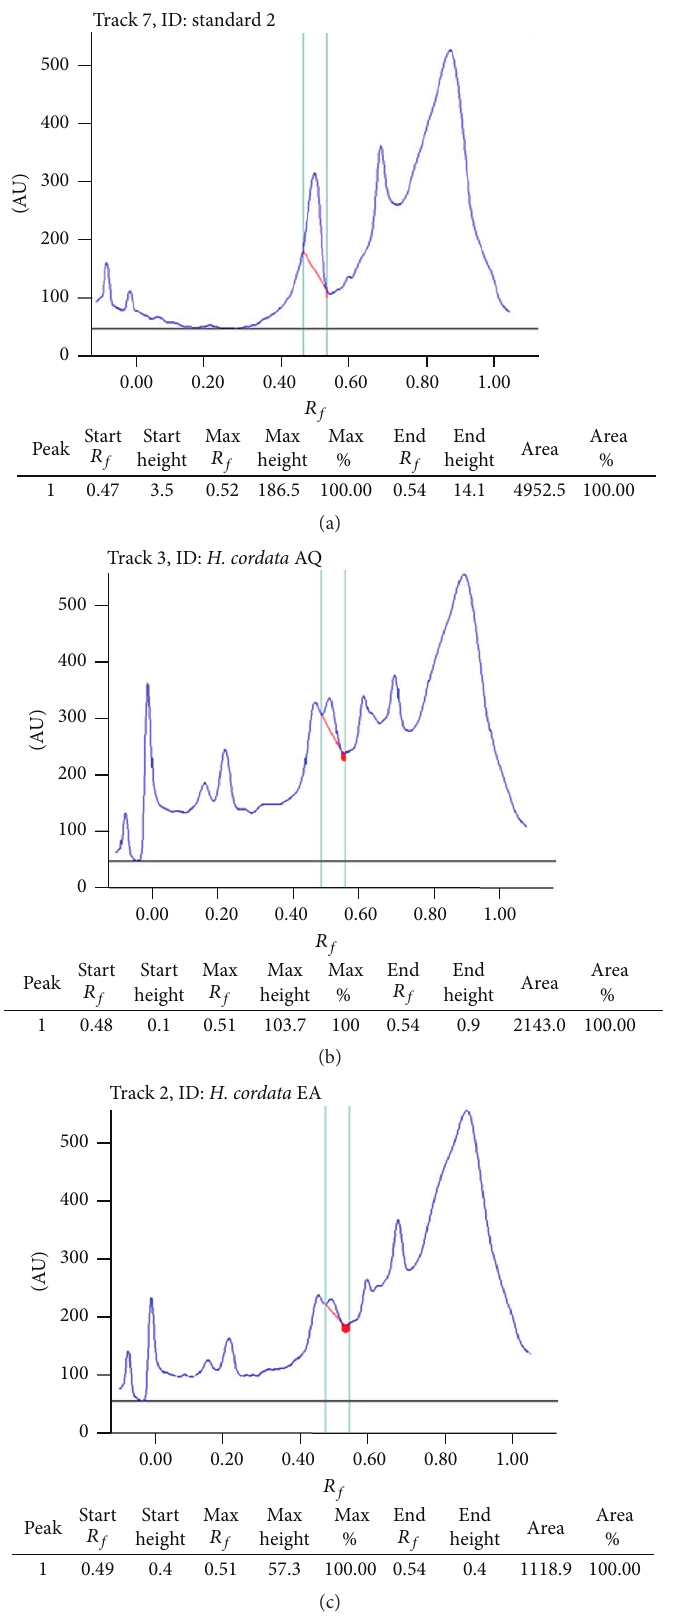
Figure 1: HPTLC chromatograms of quercetin (a); HPTLC chromatograms of quercetin in AQ fraction of H. cordata (b); HPTLC chromatograms of quercetin in EA fraction of H. cordata